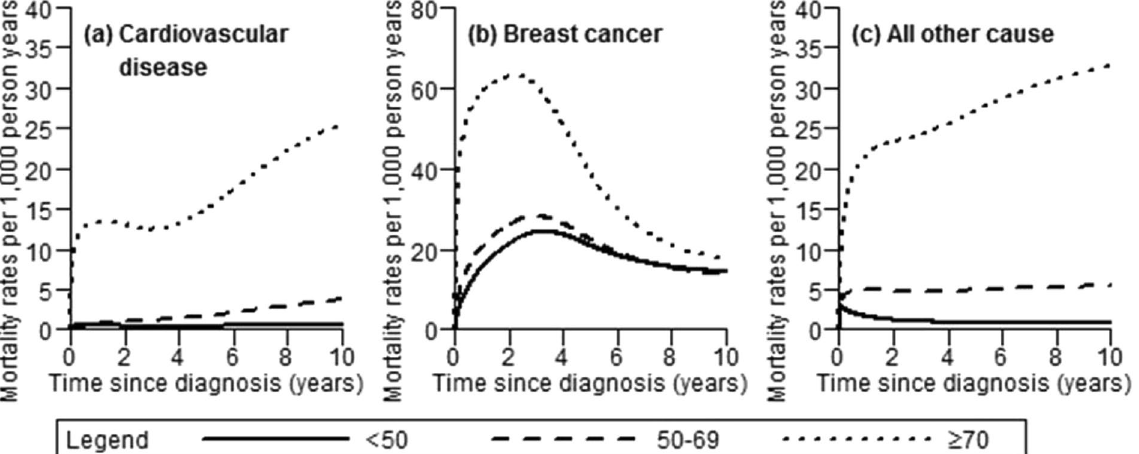
Figure 1. Estimated mortality rates within 10 years of diagnosis in Southeast Asian women with breast cancer diagnosed between 1990 and 2011 (mortality rates estimated from flexible parametric survival models with age as only covariate, allowing age effect to vary by time since diagnosis). Death due to ( a ) cardiovascular disease, ( b ) breast cancer, ( c ) all other